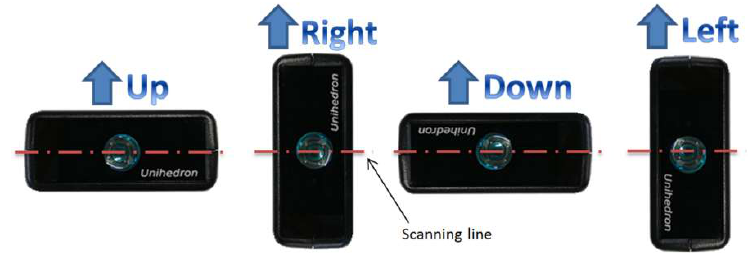
Figure 4. Overview of SQM unit orientation during measurements.